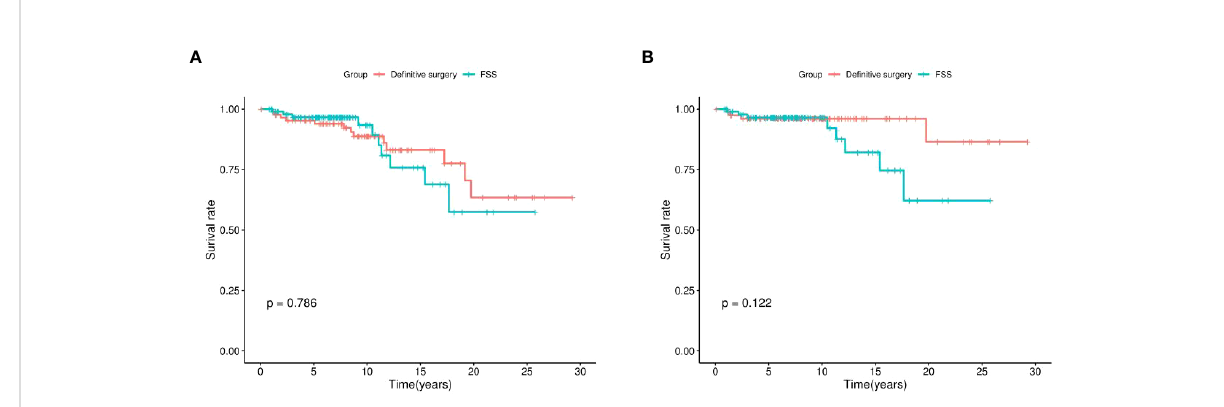
FIGURE 2 Kaplan-Meier survival analysis of de fi nitive surgery group and FSS group. (A) overall survival (OS), (B) cancer-speci fi c survival (CSS); FSS, fertility- sparing surgery.